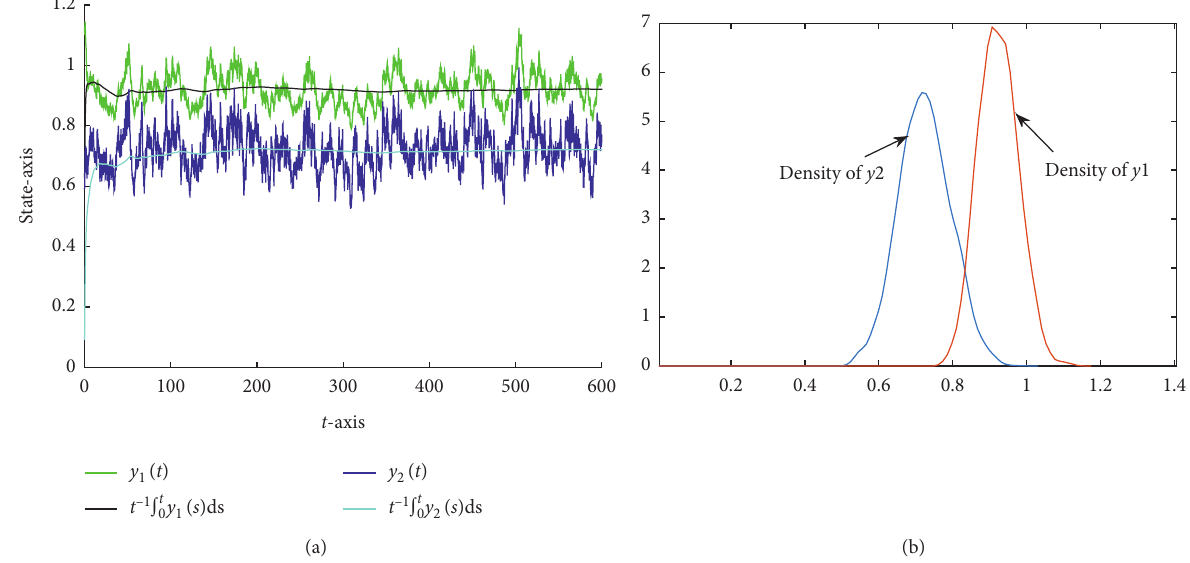
Figure 2: The persistent in mean of model ( M ) with c function of y